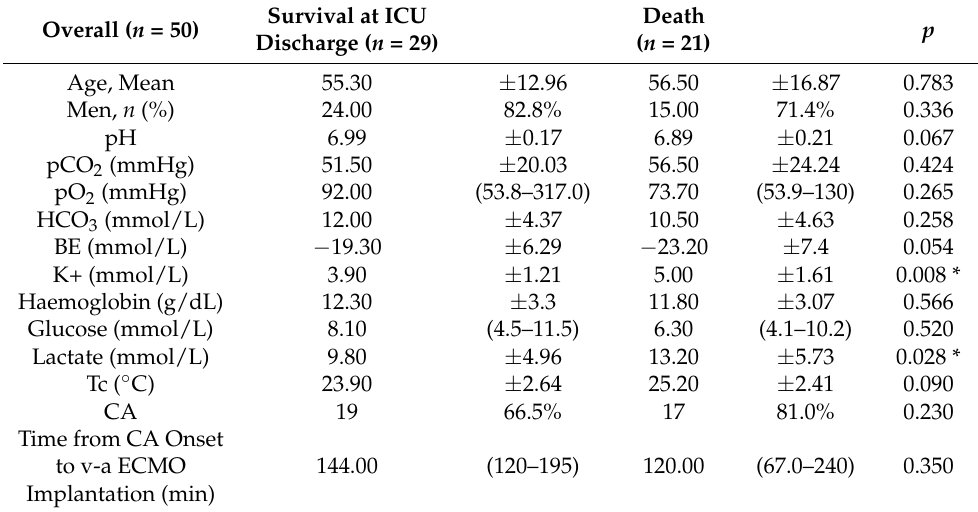
Table 1. Patients’ characteristics on